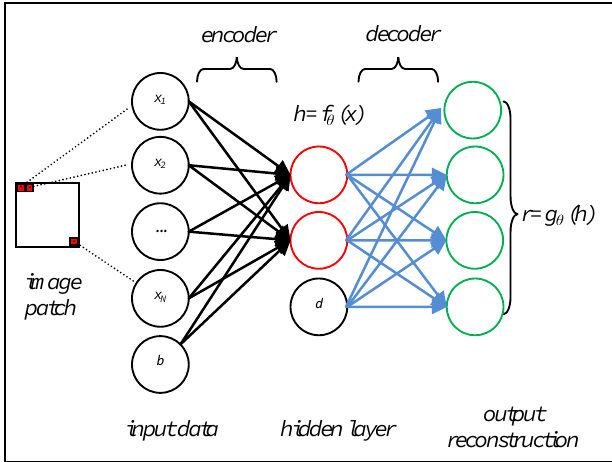
Figure 1. The Autoencoder's architecture. Input, hidden and output units are indicated by black, red and green circles,